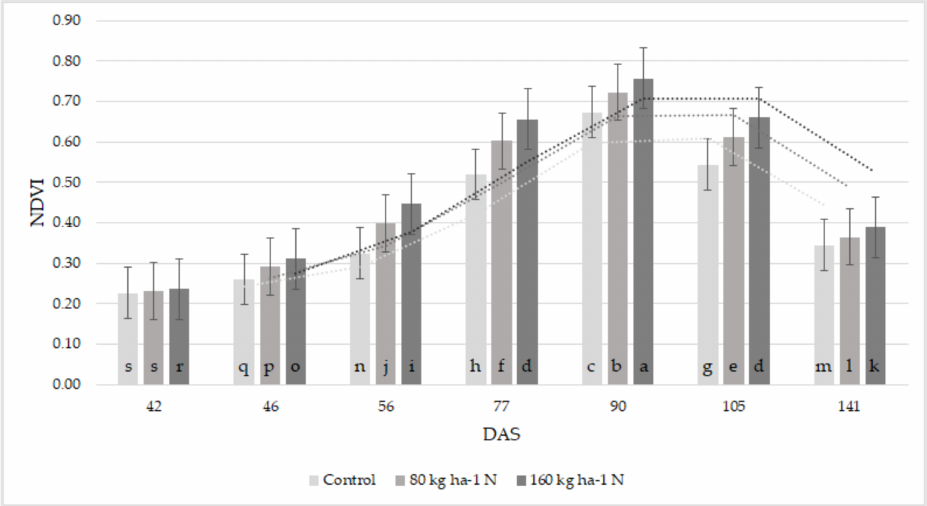
Figure 12. The NDVI UAV values of maize as the effect of fertilization treatments at different DAS (Debrecen, 2021); means of the varieties ± standard error. Different letters indicate significant difference at the p < 0.05 level among the hybrids and DAS. LSD =